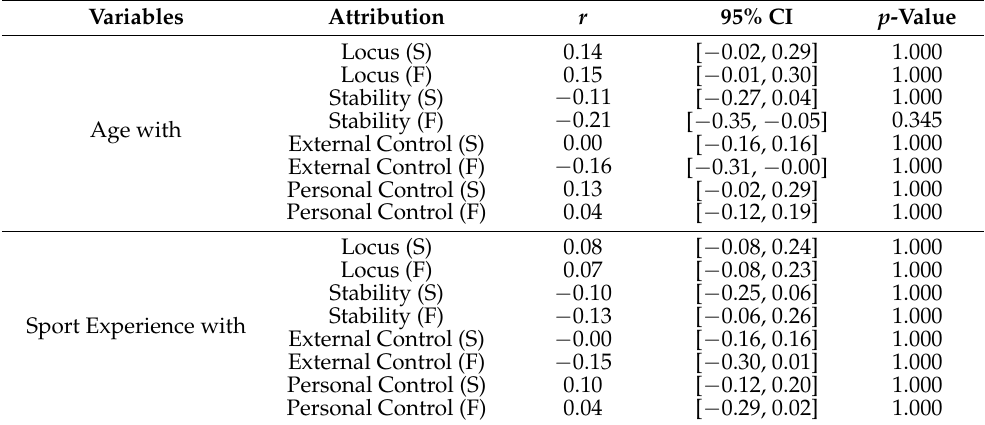
Table 2. Pearson correlations (r) with 95% confidence intervals (CI) between age and sport experience with the success (S) and failure (F) attribution dimensions with associated p -value. N = 154 for all correlations.